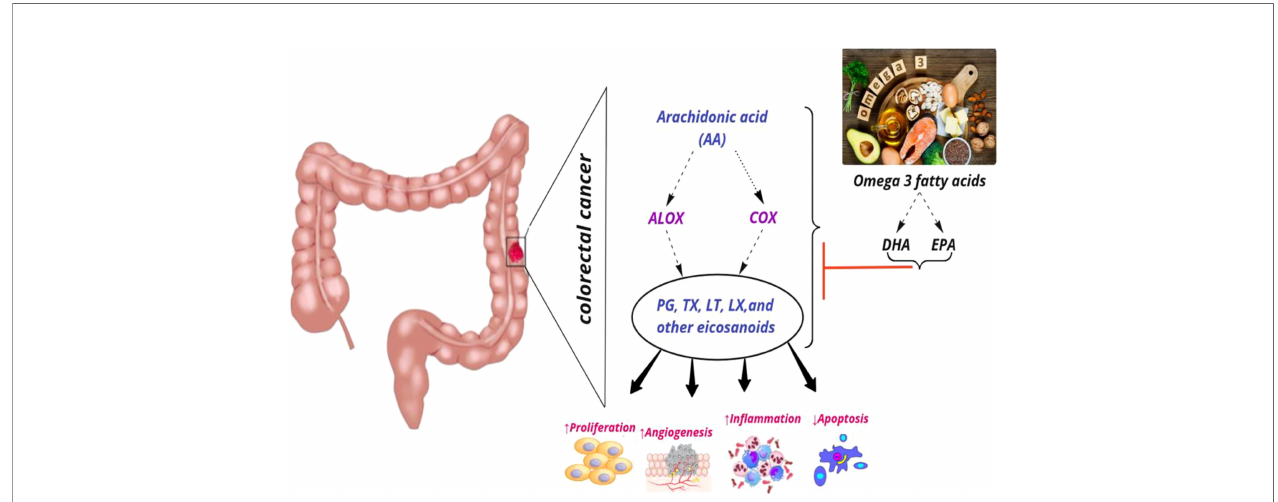
FIGURE 4 | Interaction among dietary fatty acids, ALOX (Arachidonate lipoxygenase) and COX (Cyclooxygenase) in metabolic pathway of AA (Arachidonic Acid), and CRC (colorectal cancer) risk. PG, Prostaglandin; TX, Thromboxane; LT, Leukotriene; LX, Lipoxin; DHA, Docosahexaenoic acid; EPA, Eicosapentaenoic acid; ↑ , increase; ↓ ,